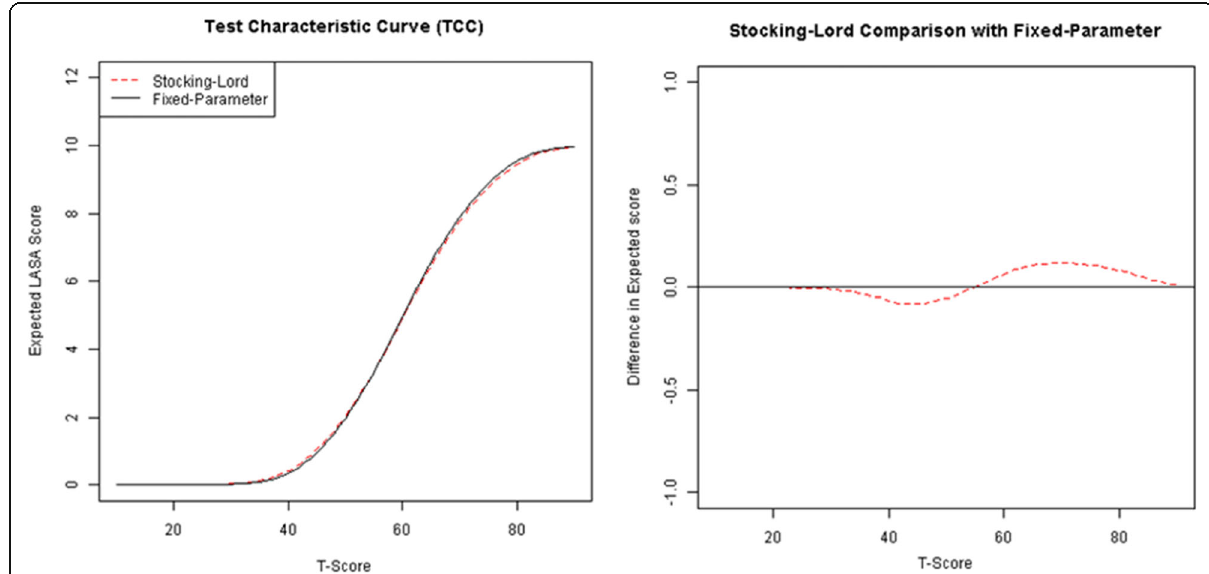
Fig. 2 Comparison of Test Characteristic Curves in NRS Anxiety scale and the Difference in Raw Score Values across the Scale between Concurrent Calibration with Linking Constants and Fixed